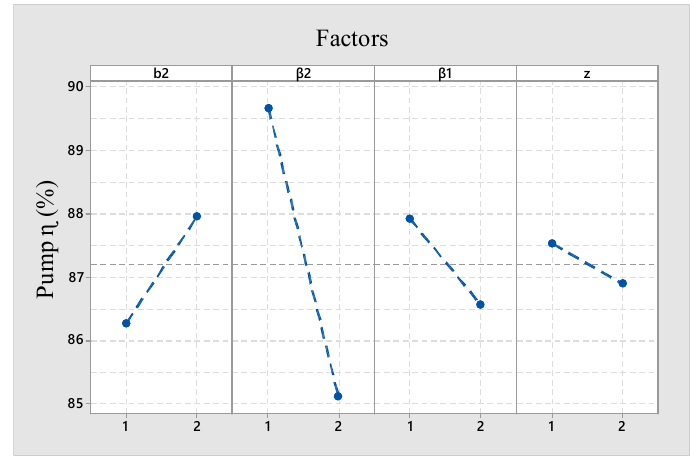
Figure 8. Level of influence of each parameter on PAT efficiency.